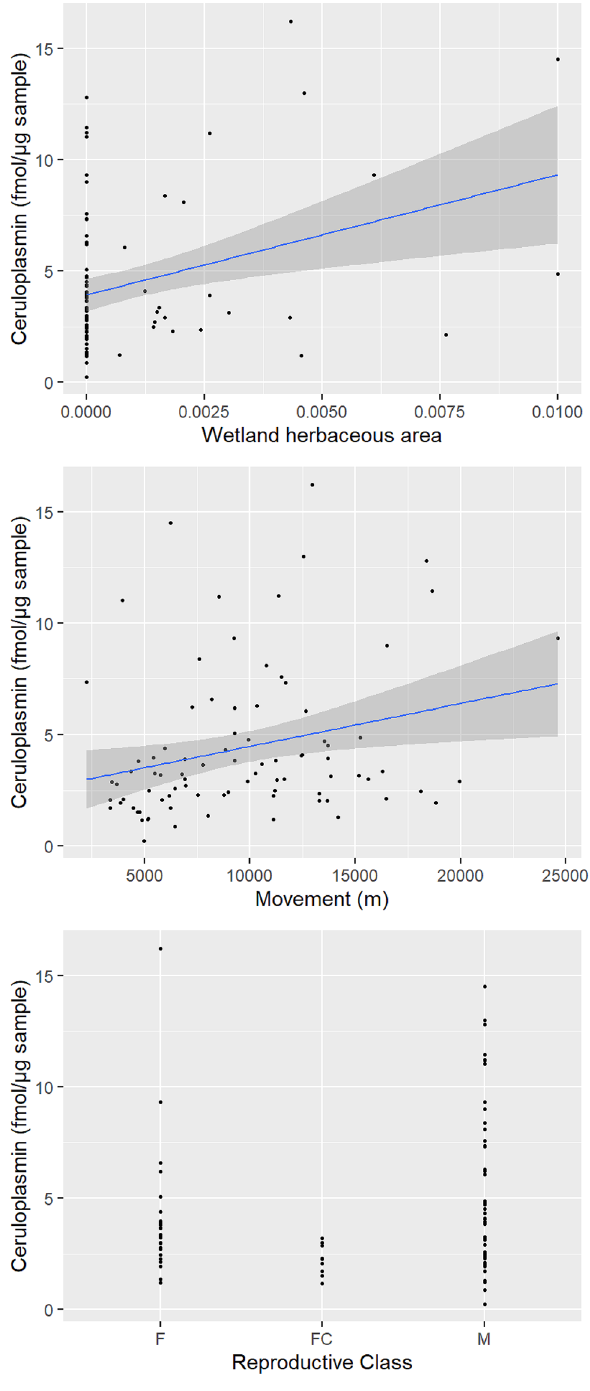
Figure 3. Estimated expression (solid blue line) of ceruloplasmin related to the wetland herbaceous area, movement, and reproductive class ( F female, FC female with cubs, M male). Grey shade is 95% confidence band and closed symbols are the raw data of protein expression. Figure was created using R statistical software version 4.0.3 and R studio version 1.3.1093 (https:// www.R- proje ct.